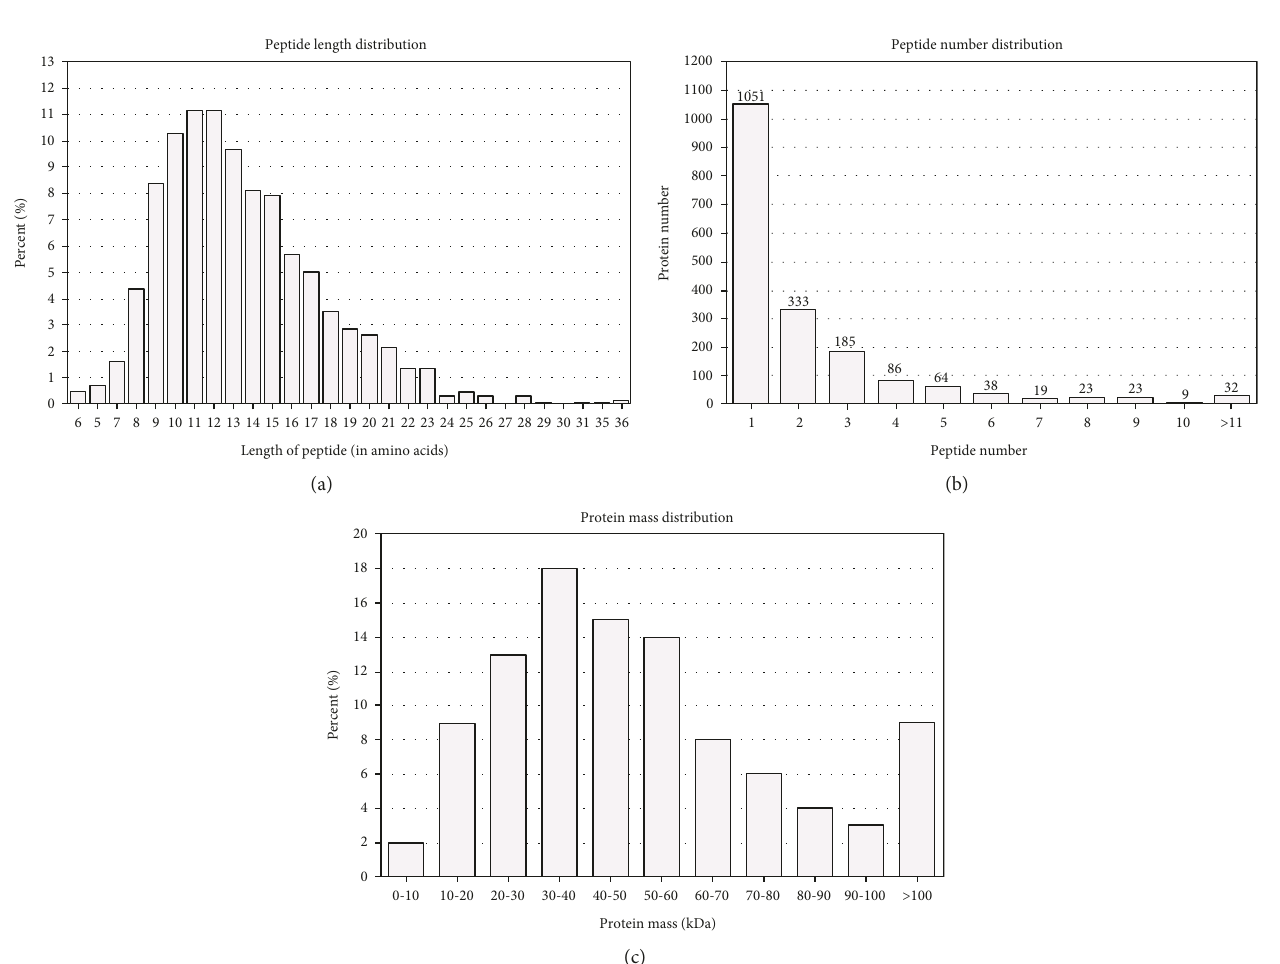
Figure 3: Statistics of basic information of proteins. (a) Percentage of di ff erent length of peptide in all peptides. (b) Distribution of matched peptide number in identi fi ed proteins. (c) Distribution of relative molecular mass of identi fi ed proteins.